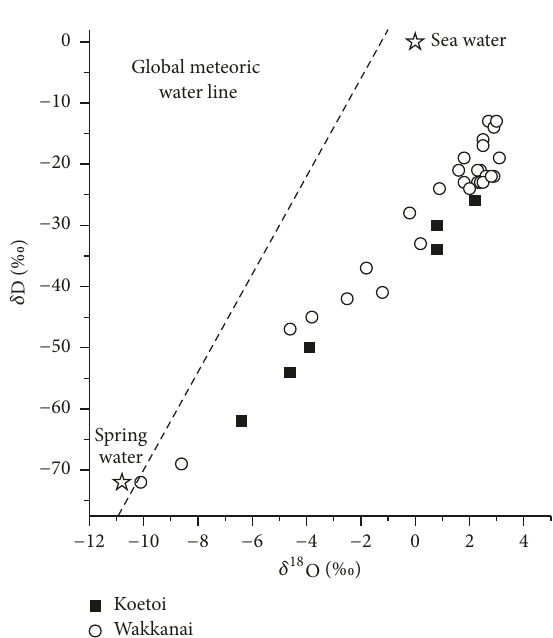
Figure 8: The relationships between 𝛿 18 O and 𝛿 D for groundwater in the studied area in the Koetoi and Wakkanai